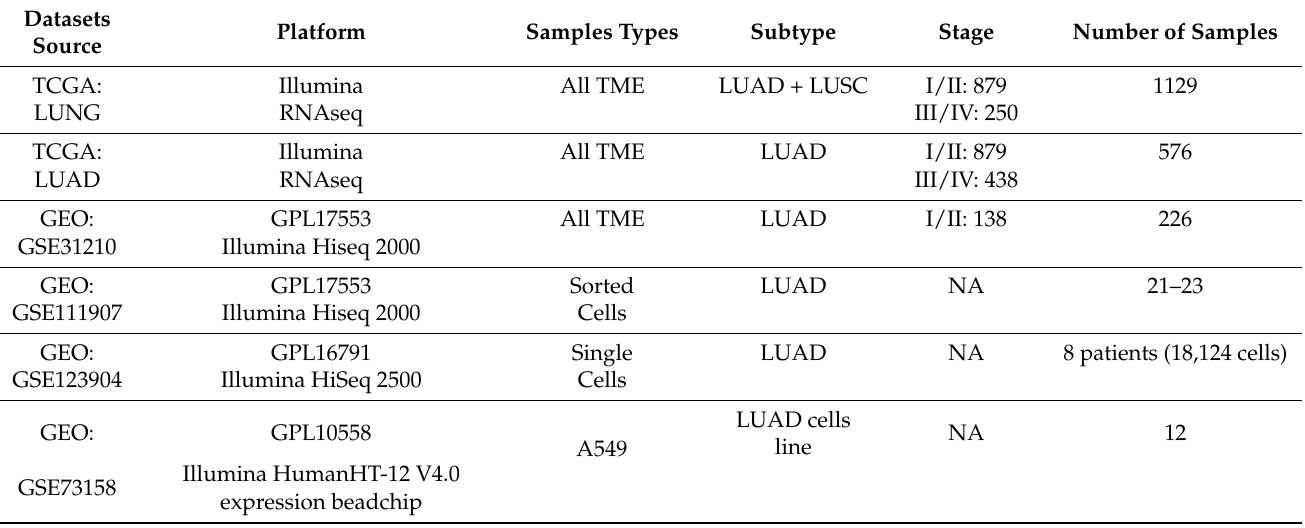
Table 1. Main information regarding our four datasets. NA means that we do not have the data. TME signifies tumor